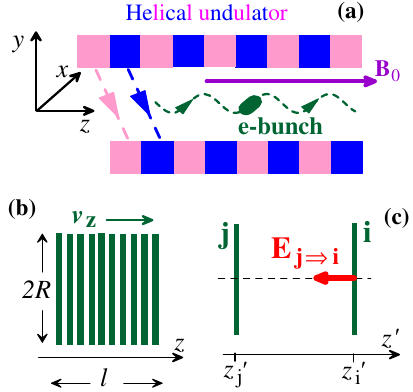
FIG. 2. (a) Electron bunch moving in a helical undulator with guiding magnetic field. (b) The model of a bunch in the form of a set of charged pancakes. (c) Electric field acting from the jth pancake to the ith